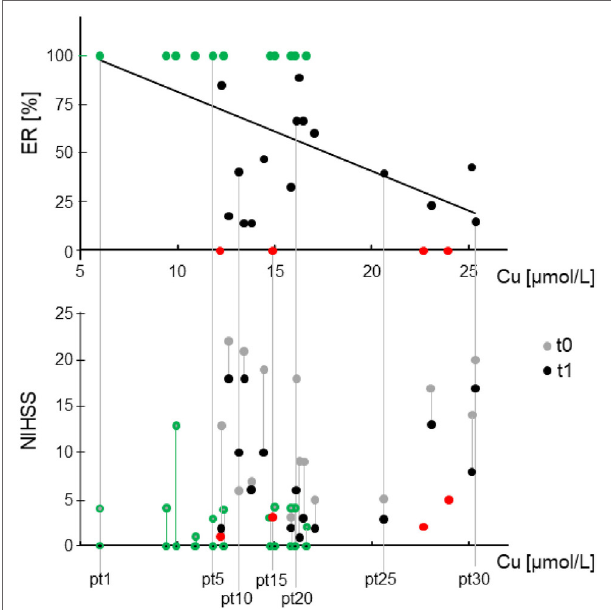
FigUre 1 | Relationship between stroke acute serum copper and recovery and clinical states. Top: scatter plot of the effective recovery (ER) in relationship with the total copper in acute phase, the only variable entering the regression model explaining 24% of ER variance. Bottom: clinical state scored by National Institute of Health Stroke Scale (IHSS) in acute (t0) and stabilized phase (t1) expressed in function of the total copper ( x -axis) to identify single patients in terms of recovery (top section) and clinical states (bottom). It is visible that the absence of correlation of total copper with NIHSS at t0. It is also noticeable that people with total copper above 20 µmol/L in t0 recover poorly, in particular patients 26 and 28 (order determined by copper level) had minimal and mild symptoms in t0 which did not ameliorate at all. In red, the four people who did not recover at all, i.e., ER = 0, NIHSS at t0 = NIHSS at t1. In green (dots top, contours bottom), the 11 people who recovered completely (ER = 1, NIHSS at t1 = 0).